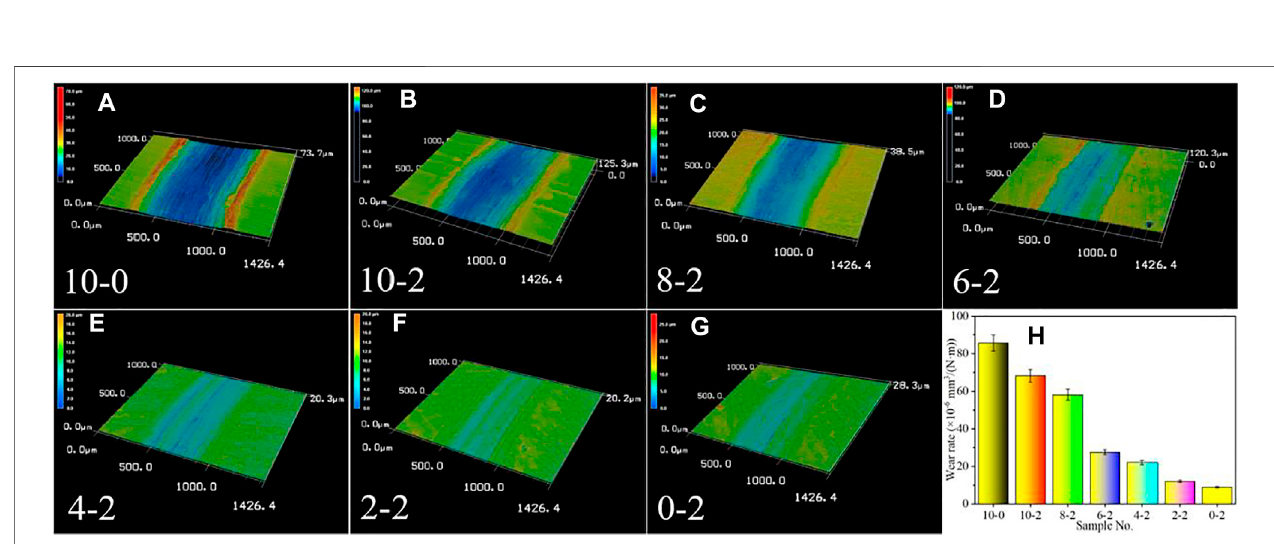
FIGURE 9 | 3D skeleton map of wear tracks and their wear rates of the samples with different Co contents. (A – G) 3D skeleton map of wear tracks of the samples and (H) the wear rate of the samples after 1,800 s.